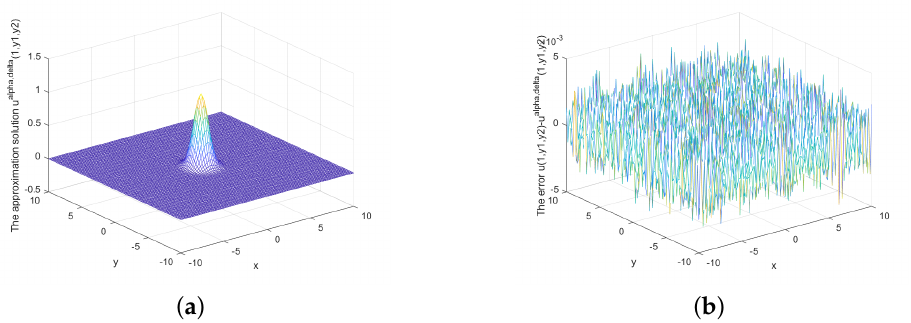
Figure 7. ( a ) The regularized solution and ( b ) error between regularized and exact solution when x = 0.2, δ = 1 × 10 − 3 under the posterior rule.